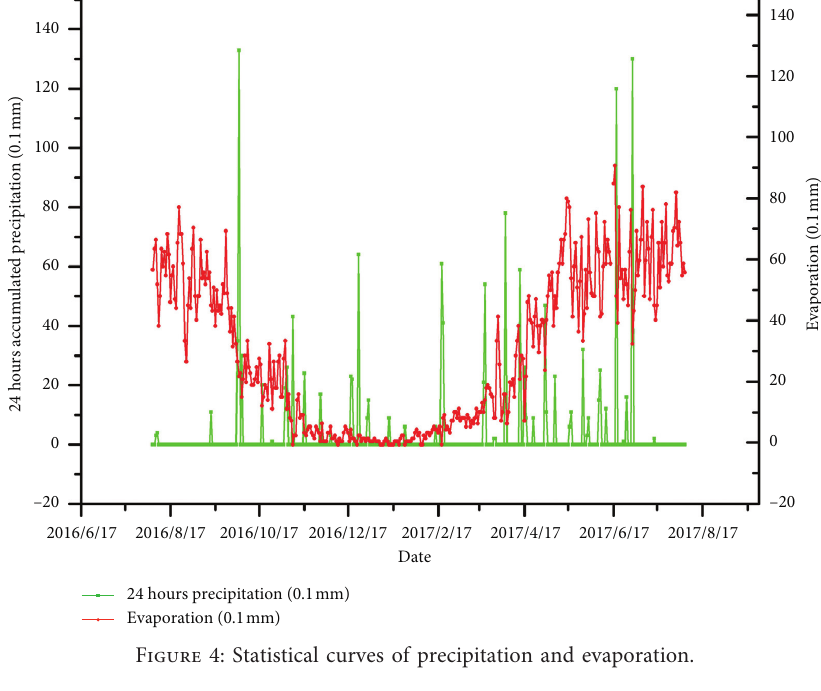
Figure 4: Statistical curves of precipitation and